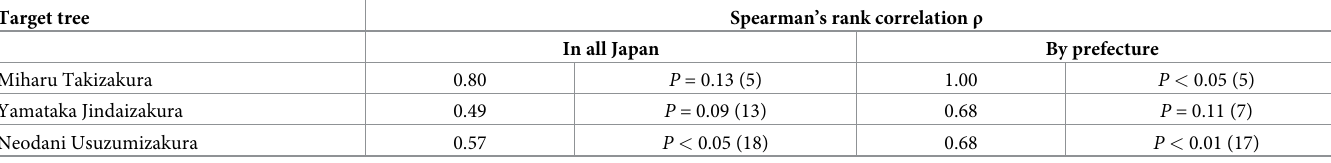
Table 2. Statistical relationship between the year-to-year variability of the date when the time-series of RSV reaches a maximum in all Japan and by prefecture and that of the first date of full bloom. Target